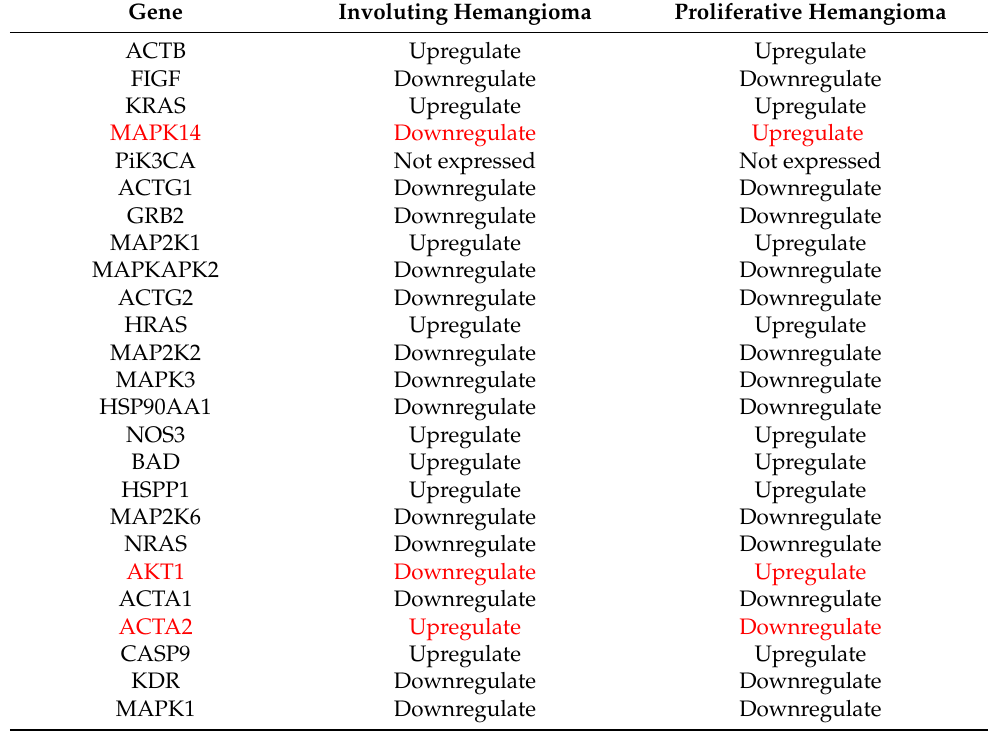
Table 1. Gene amplification differences between the involuting and proliferative hemangioma. Gene Involuting Hemangioma Proliferative Hemangioma ACTB Upregulate Upregulate